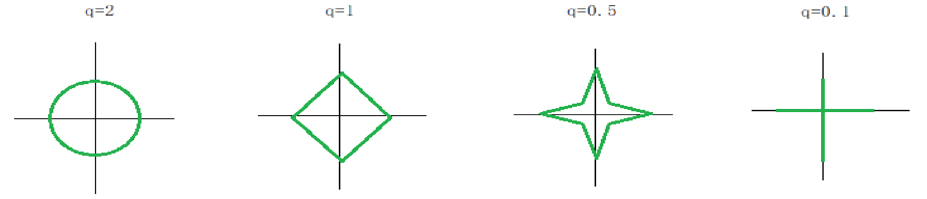
Figure 7. Constraint domain of ridge